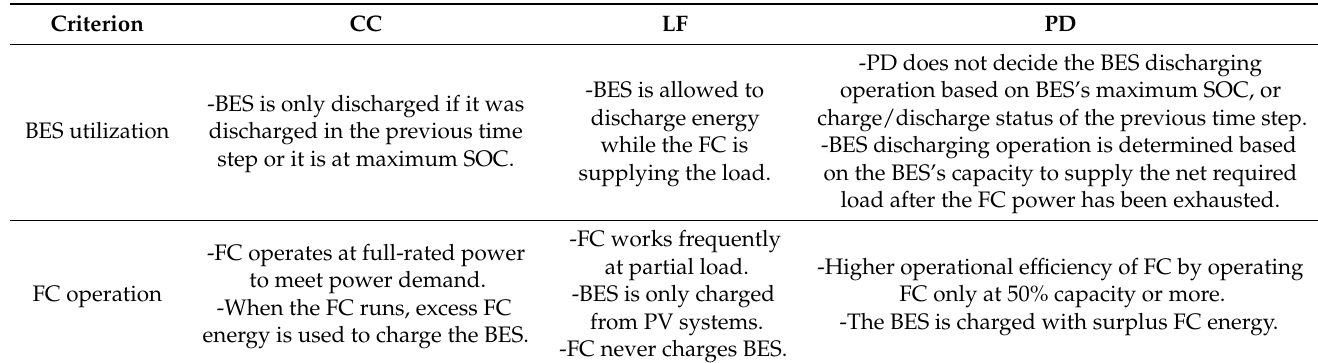
Table 6. Overview of the key differences between CC, LF, and PD